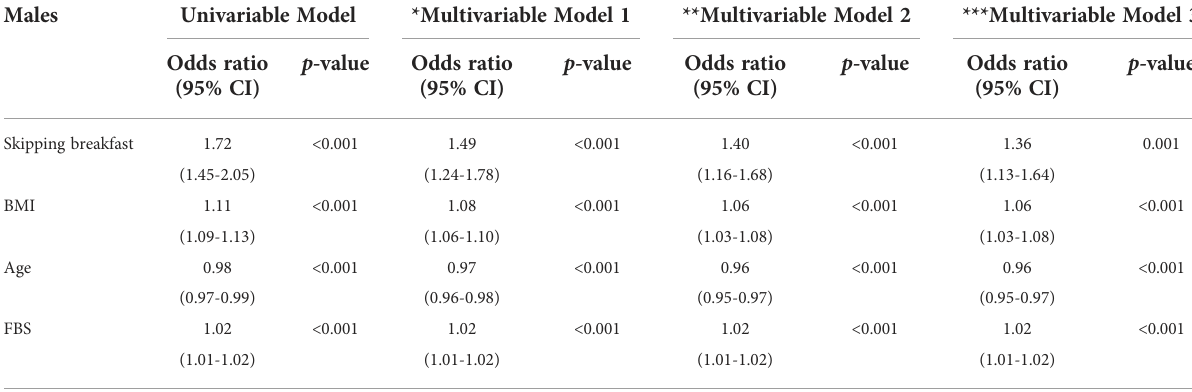
TABLE 2A Logistic regression analysis for the prevalence of proteinuria above 1+ in males.